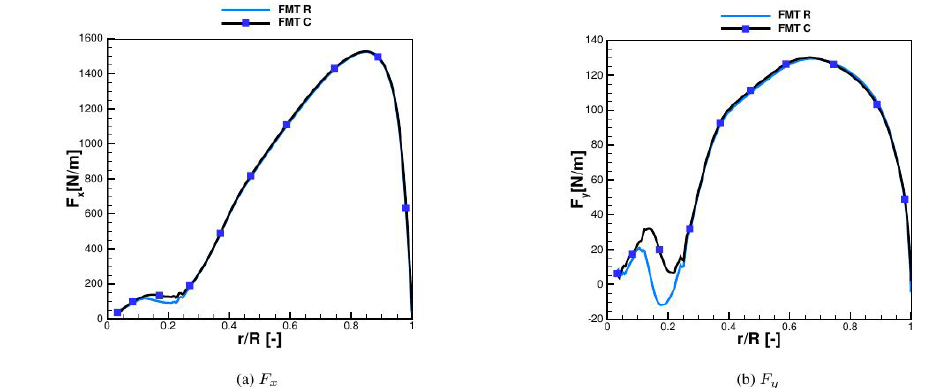
Figure 19. Sectional loads in FMT: comparison between rigid (R) and coupled (C) calculated with